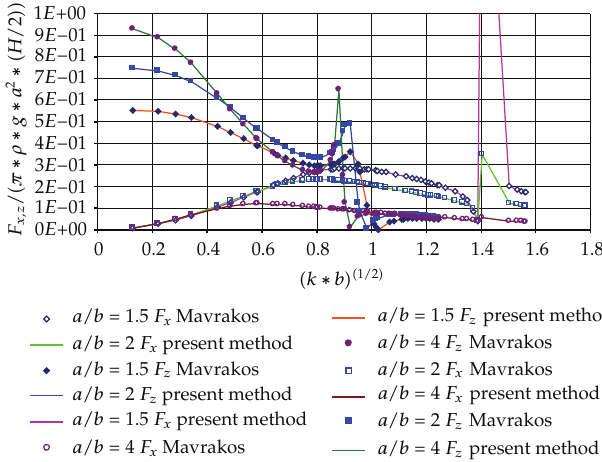
Figure 2: Horizontal and vertical exciting force on the OWC device for di ff erent cases of wall